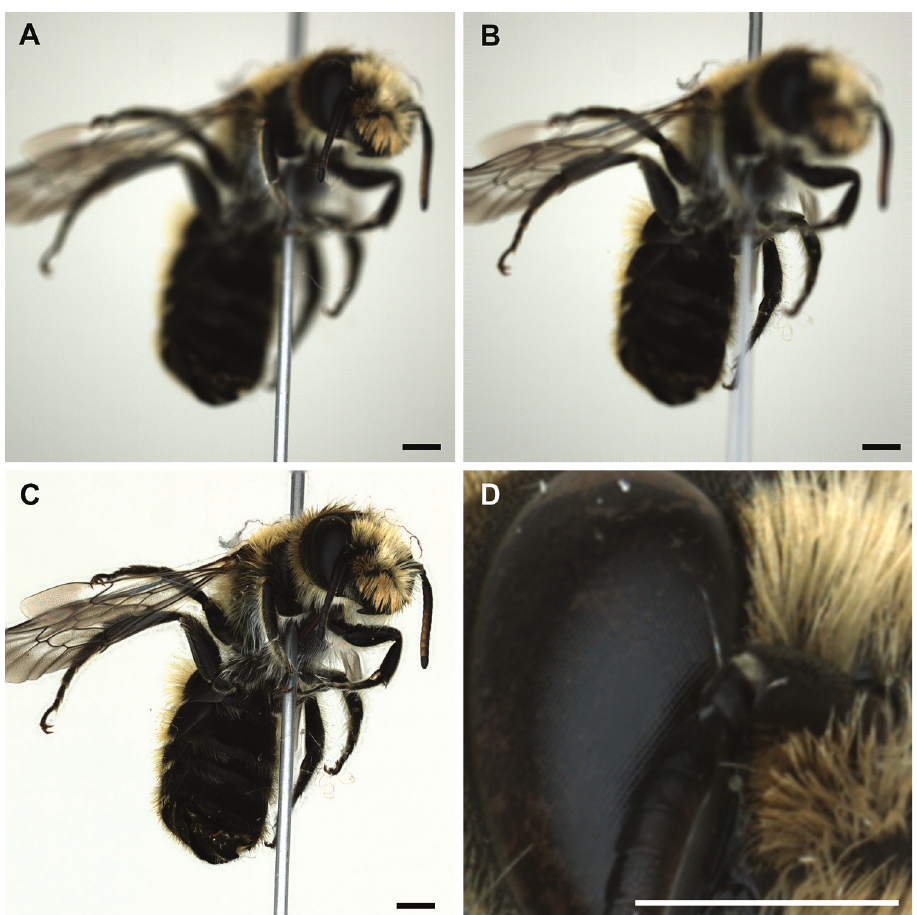
Figure 7. Osmia adunca , two exemplary raw images of the front-light stack, with the focal plane going through the proximal ( A ) and the distal part ( B ) of the sample, the EDOF image ( C ), and a detail of the latter ( D ) demonstrate the resolution. Scale bars: 1